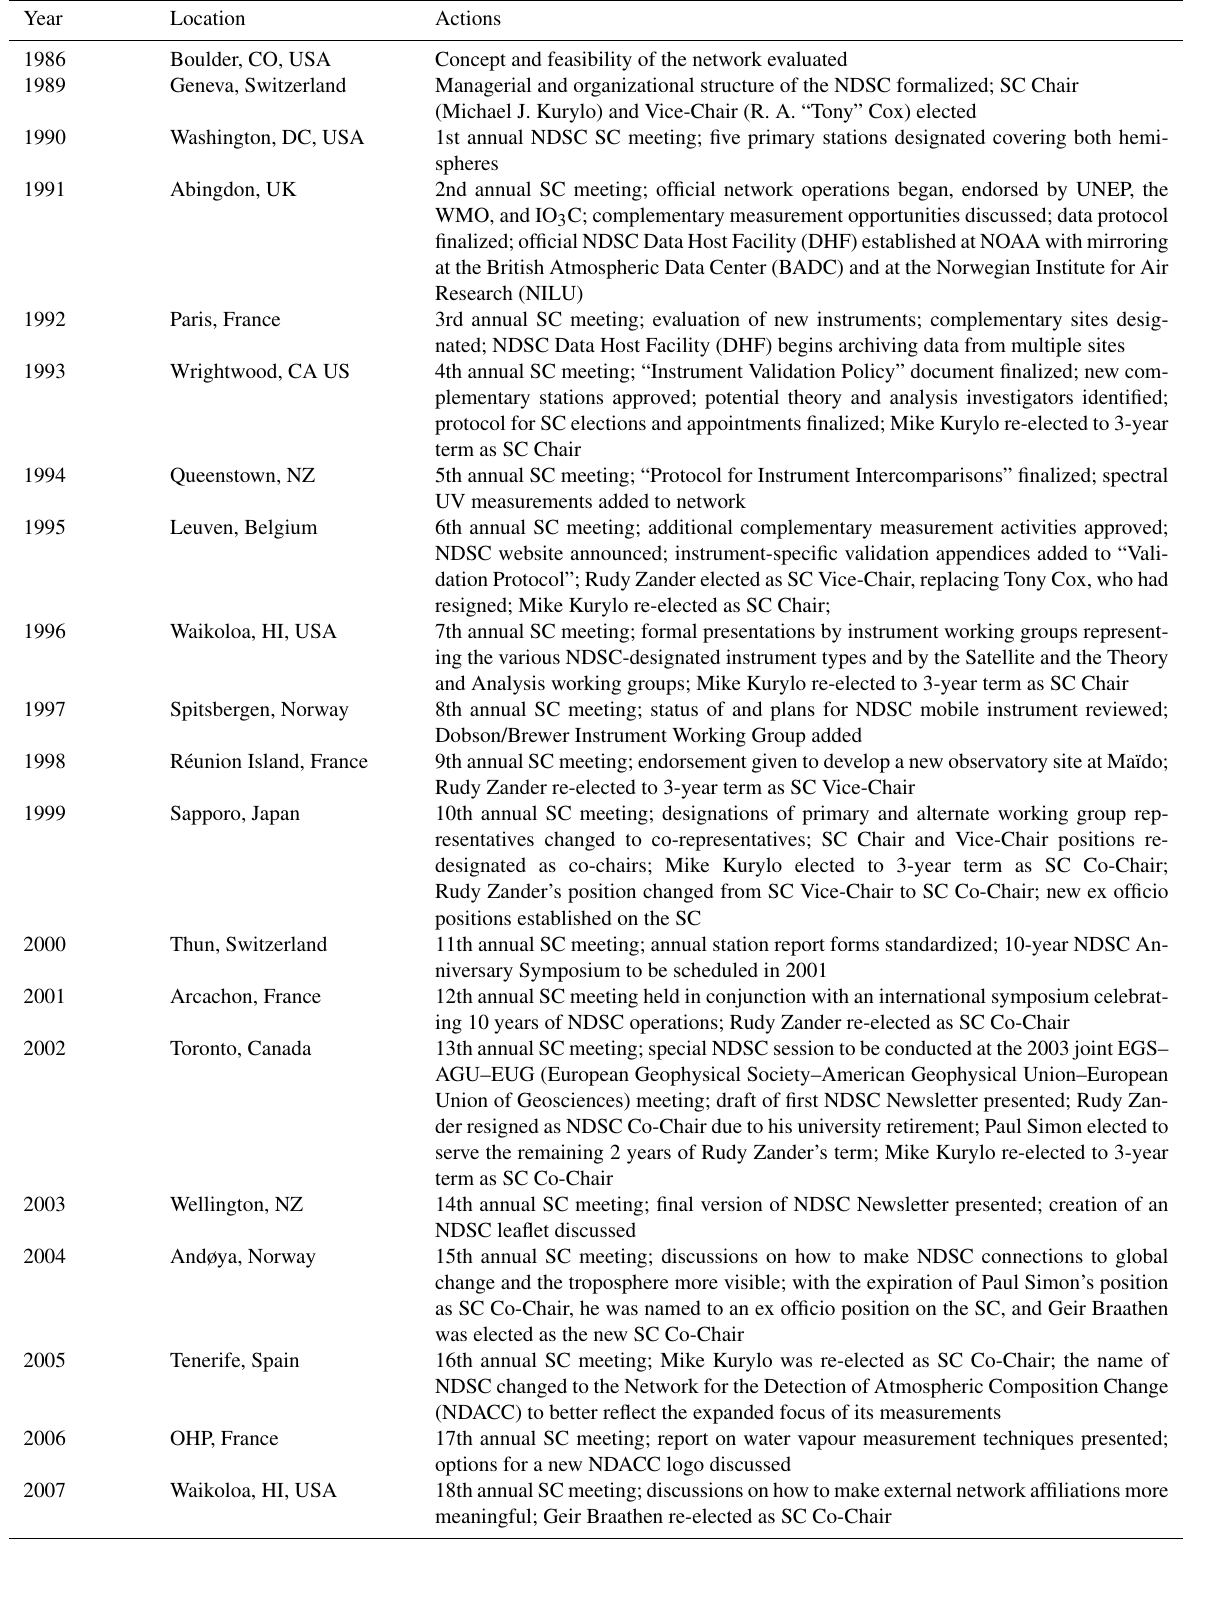
Table 1. NDSC/NDACC meeting history and key actions and Steering Committee (SC) Chair and Co-Chair